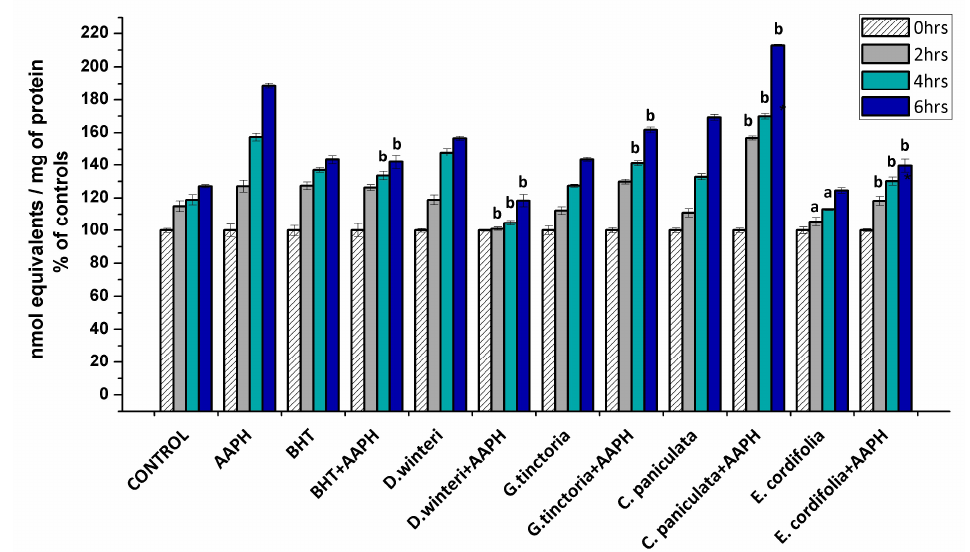
Figure 2. Concentration of carbonyl groups in the different samples analyzed, control, AAPH (10 mM), BHT (1 mM), and plant extracts (0.1 g/mL), ( p < 0.05; a significant difference compared to control group; b significant difference compared to AAPH group, ANOVA, Tukey test). Data are expressed as percentage of initial concentrations and represent the mean ± SD for of three replicates in triplicate.